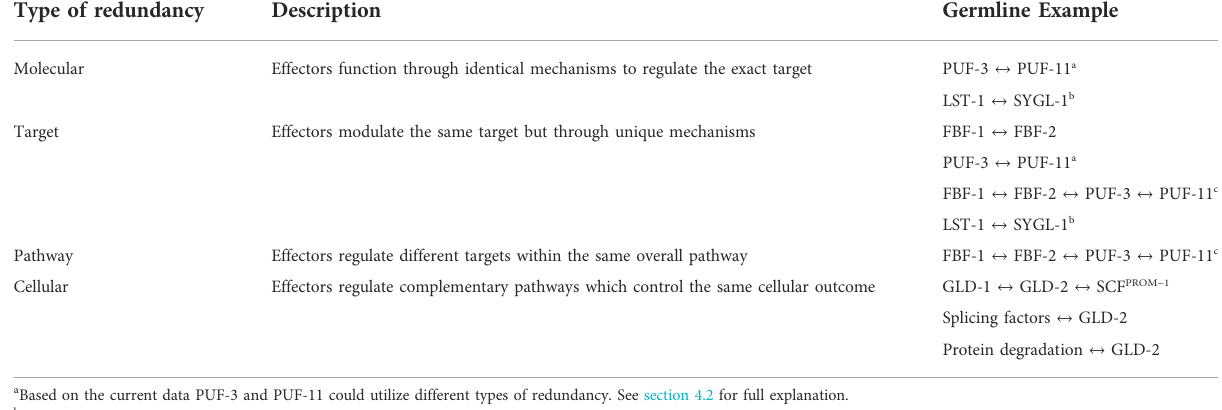
TABLE 1 Examples of redundancy within the C. elegans proliferation versus differentiation